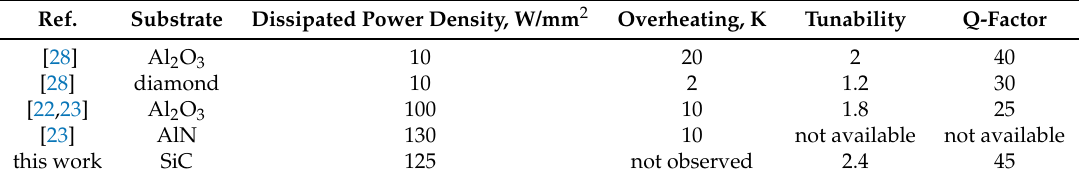
Table 1. Comparative data for the power handling capability of barium–strontium titanate (BST) capacitors on different